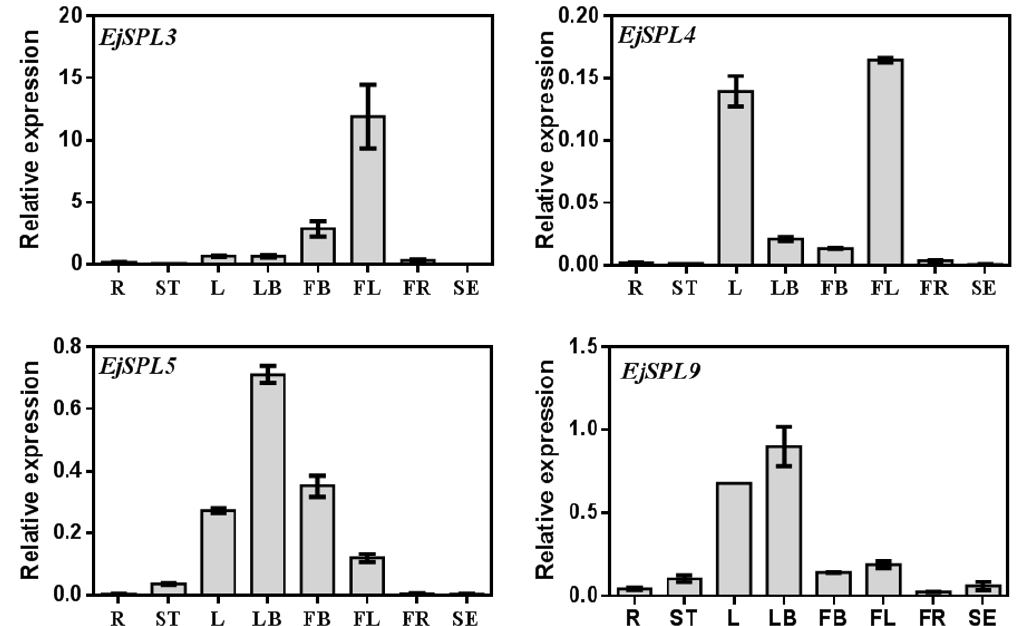
Figure 3. Relative expression levels of SPL genes in the different tissues of “JFZ”. The Y-axis represents different tissues, and the X-axis represents the relative expression of the EjSPL gene of “JFZ”. R—root, ST—stem, L—mature leaf (2017.4.28), LB—leaf bud (2017.04.28), FB—flower bud (2017.8.18), FL—flower (2017.12.08), FR—fruit (2017.3.17), SE—seed. Ejβ-actin as an internal control. Error bars indicating SE from three biological replicates.